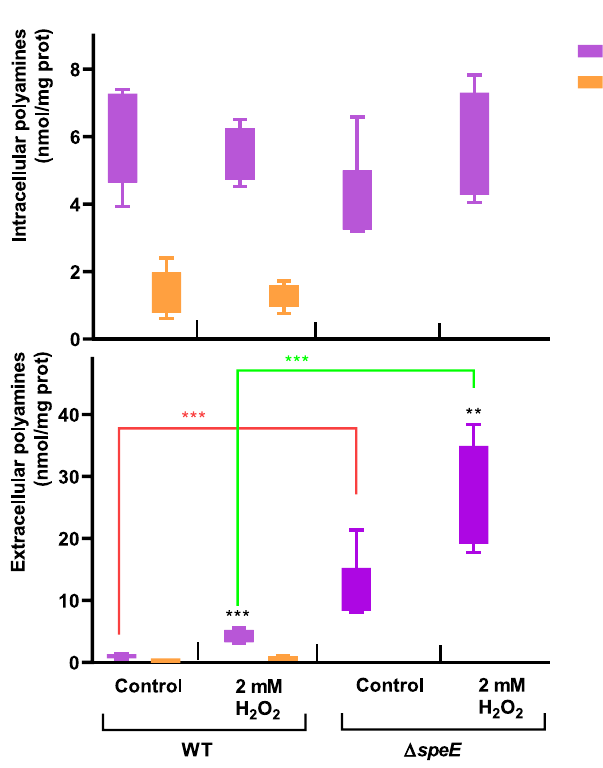
Figure 5. Effect of H 2 O 2 in the intracellular and extracellular polyamine concentrations of the wild type and ∆s peE strain. Cells were grown for 6 h in control M9 media or M9 supplemented with H 2 O 2 at a final concentration of 2 mM. Polyamine concentration was determined in the intracellular (top graph) and extracellular (bottom graph) compartments as described in Materials and Methods. Concentrations of polyamines in treated cells were compared to those obtained under control conditions using the Student’s t test. In addition, statistically significant differences in concentrations between strains under the same treatment are shown in red and green square brackets (**p < 0.05, ***p <